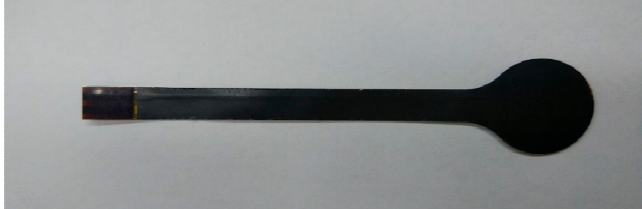
Figure 3. Photograph of the PVDF sensor (single sensing point).